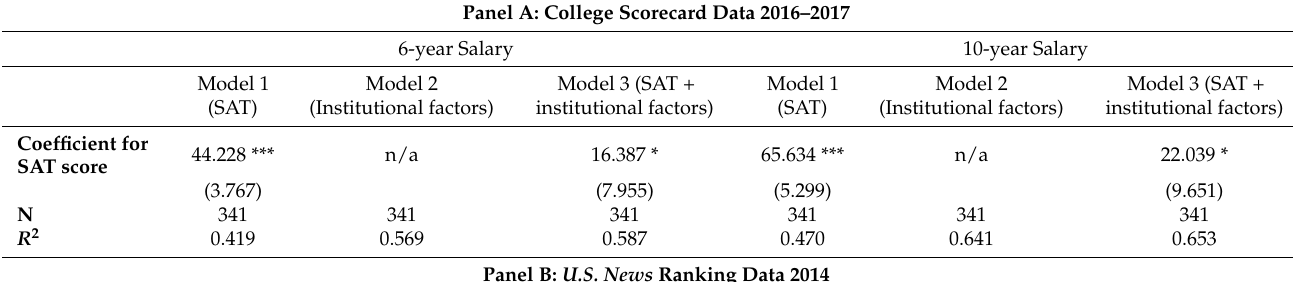
Table 2. OLS regression coefficients of SAT/ACT and institutional factors predicting salary. Panel A: College Scorecard Data